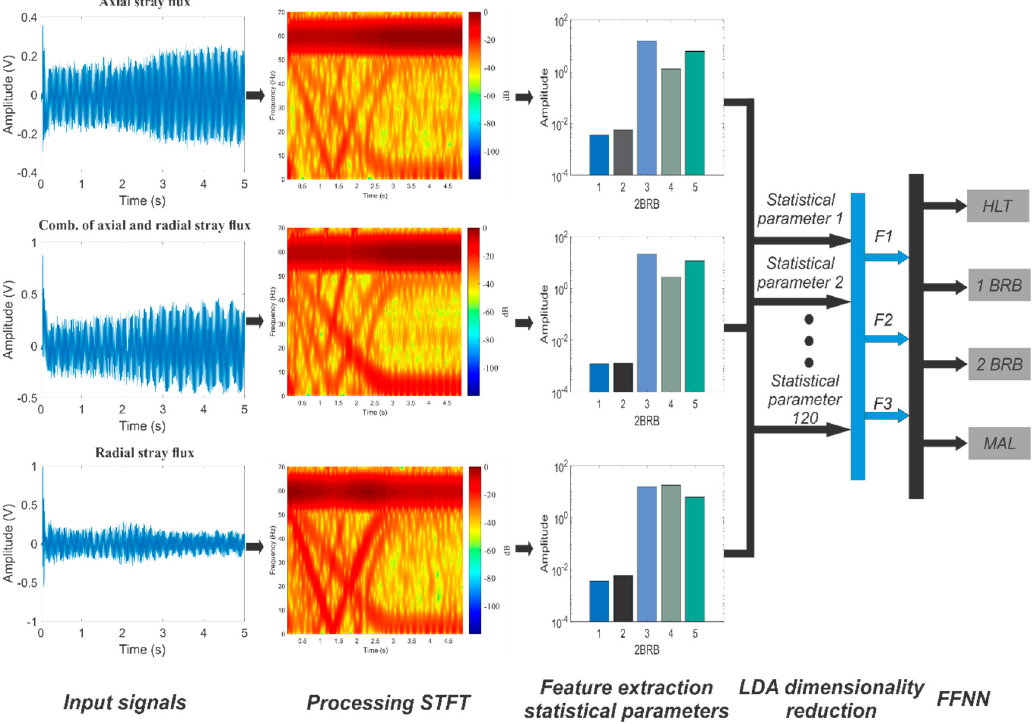
Figure 9. Proposed methodology flow–up.